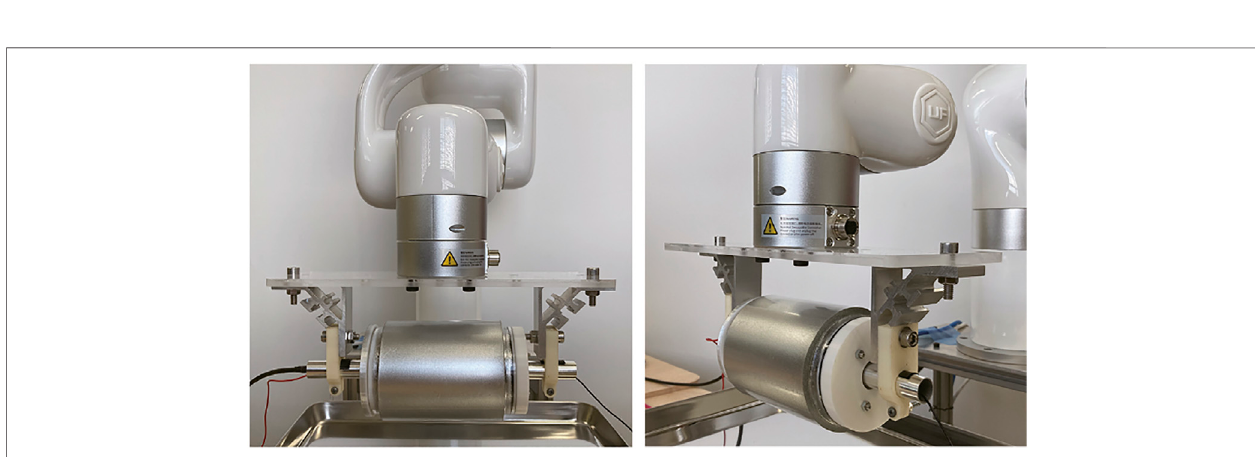
FIGURE 3 | Pictures of the robotic arm equipped with the cylindrical tactile image sensor.